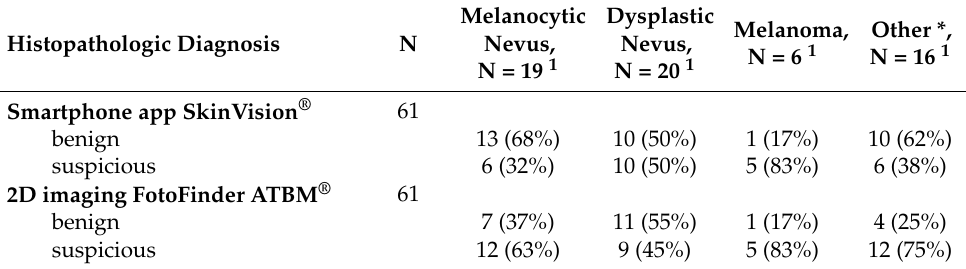
Table 3. Diagnostic accuracy of the AI-based smartphone app SkinVision ® , 2D imaging FotoFinder ATBM ® , 3D imaging Vectra ® WB360, dermatologists, and dermatologists in combination with AI in melanoma detection based on histopathology: sensitivity and specificity.